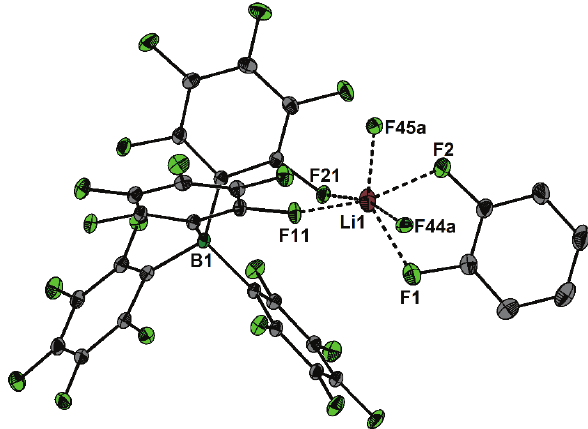
C H )][B(C F ) ] ( 1 ) showing 2 6 4 6 5 4